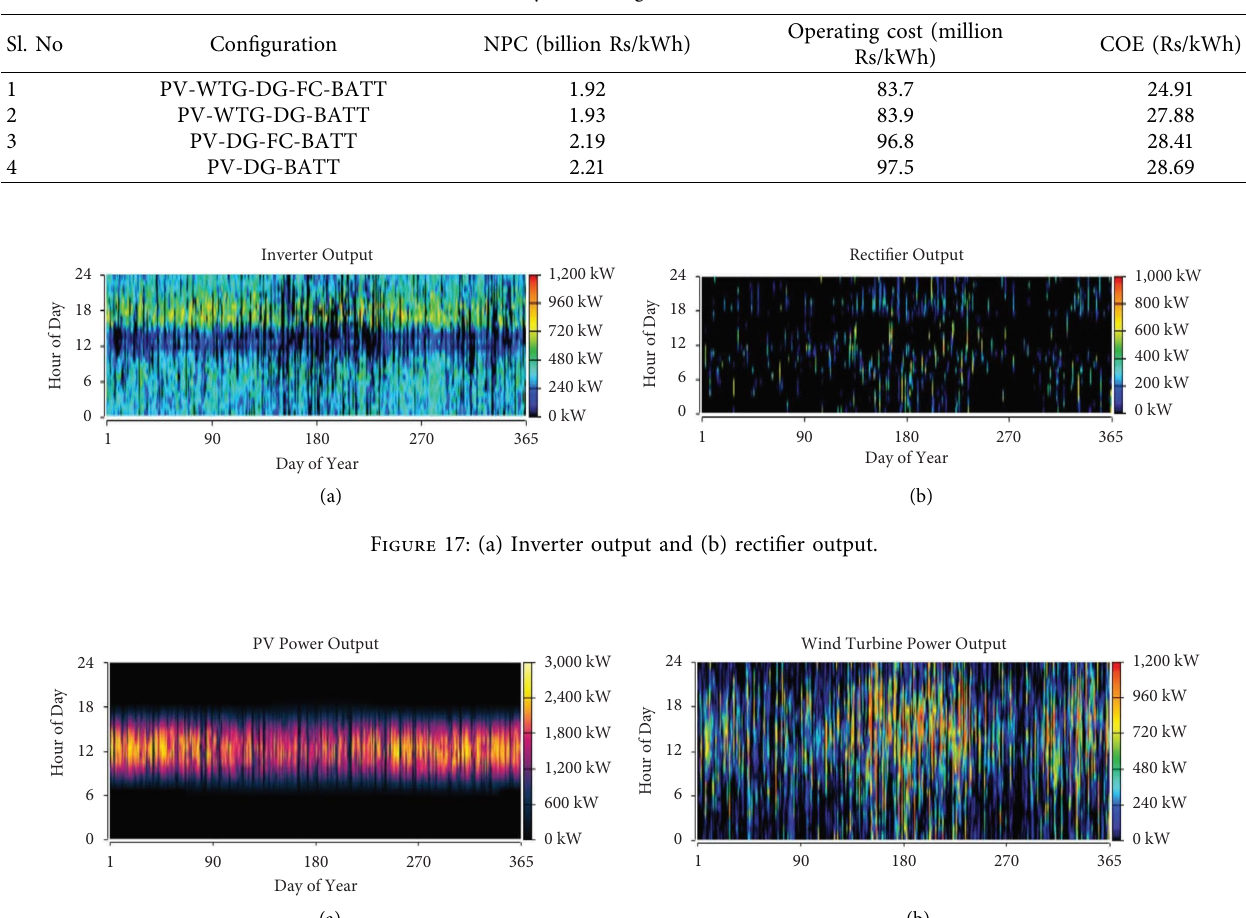
Figure 16: Hourly operation of both AC load and DC load according to HOMER. Table 1: Hybrid confgurations and COE.